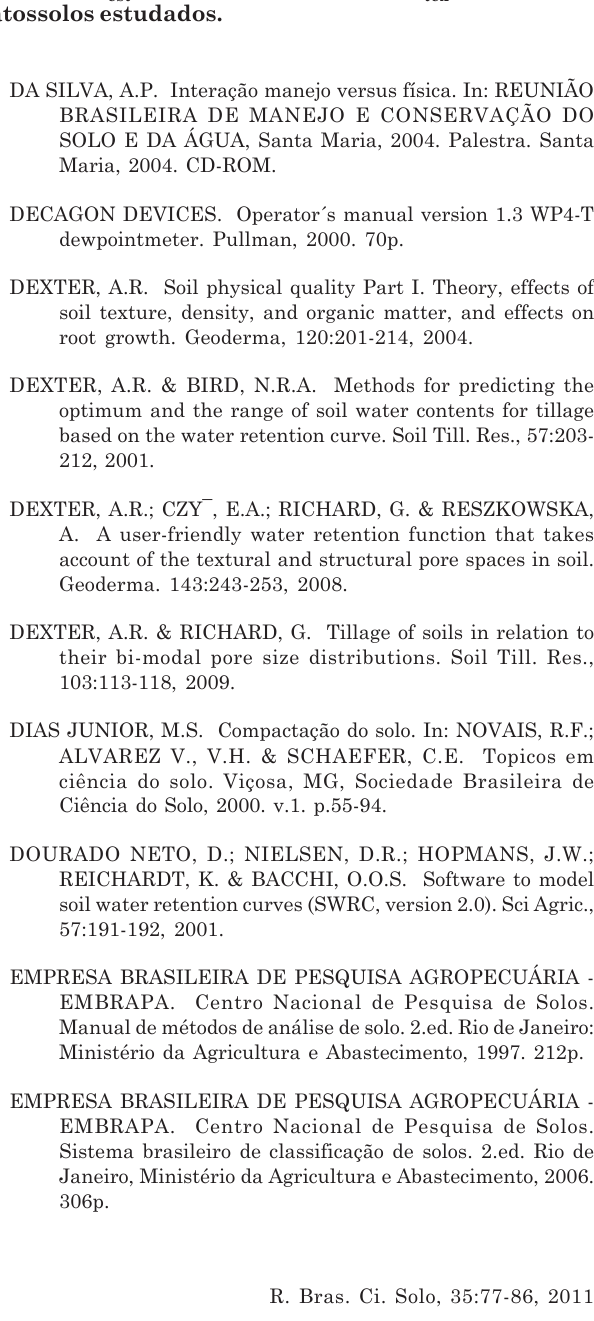
) e a segunda inclinação (I ) da curva de est tex